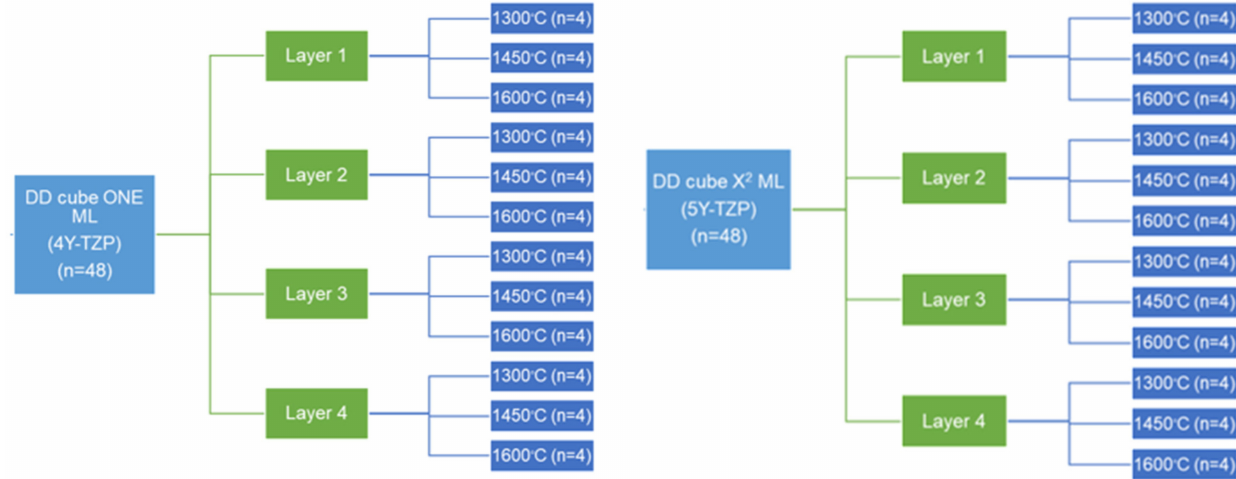
Figure 1. Study design and distribution of plate-shaped samples from each layer for Vickers micro- hardness